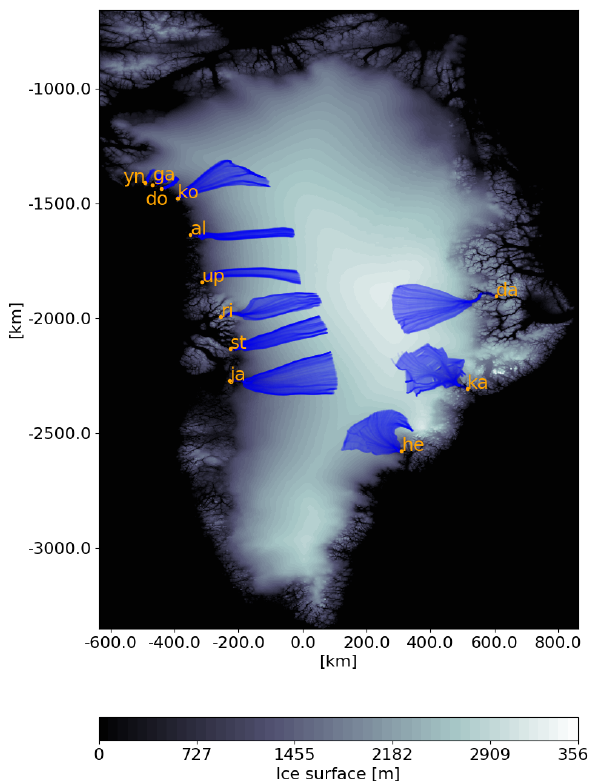
Figure 3. Terminus location (orange dot) with the catchment area (blue) of the 12 investigated glaciers: Alison Glacier (al), Daugaard- Jensen Glacier (da), Docker Smith Glacier (do), Gade (ga) Helheim Glacier (he), Jakobshavn Isbrae (ja), Kangerlussuaq Glacier (ka), King Oscar Glacier (ko), Rink Isbrae (ri), Store Glacier (st), Uper- navik Isstrom N (up), Yngvar Nielsen Glacier